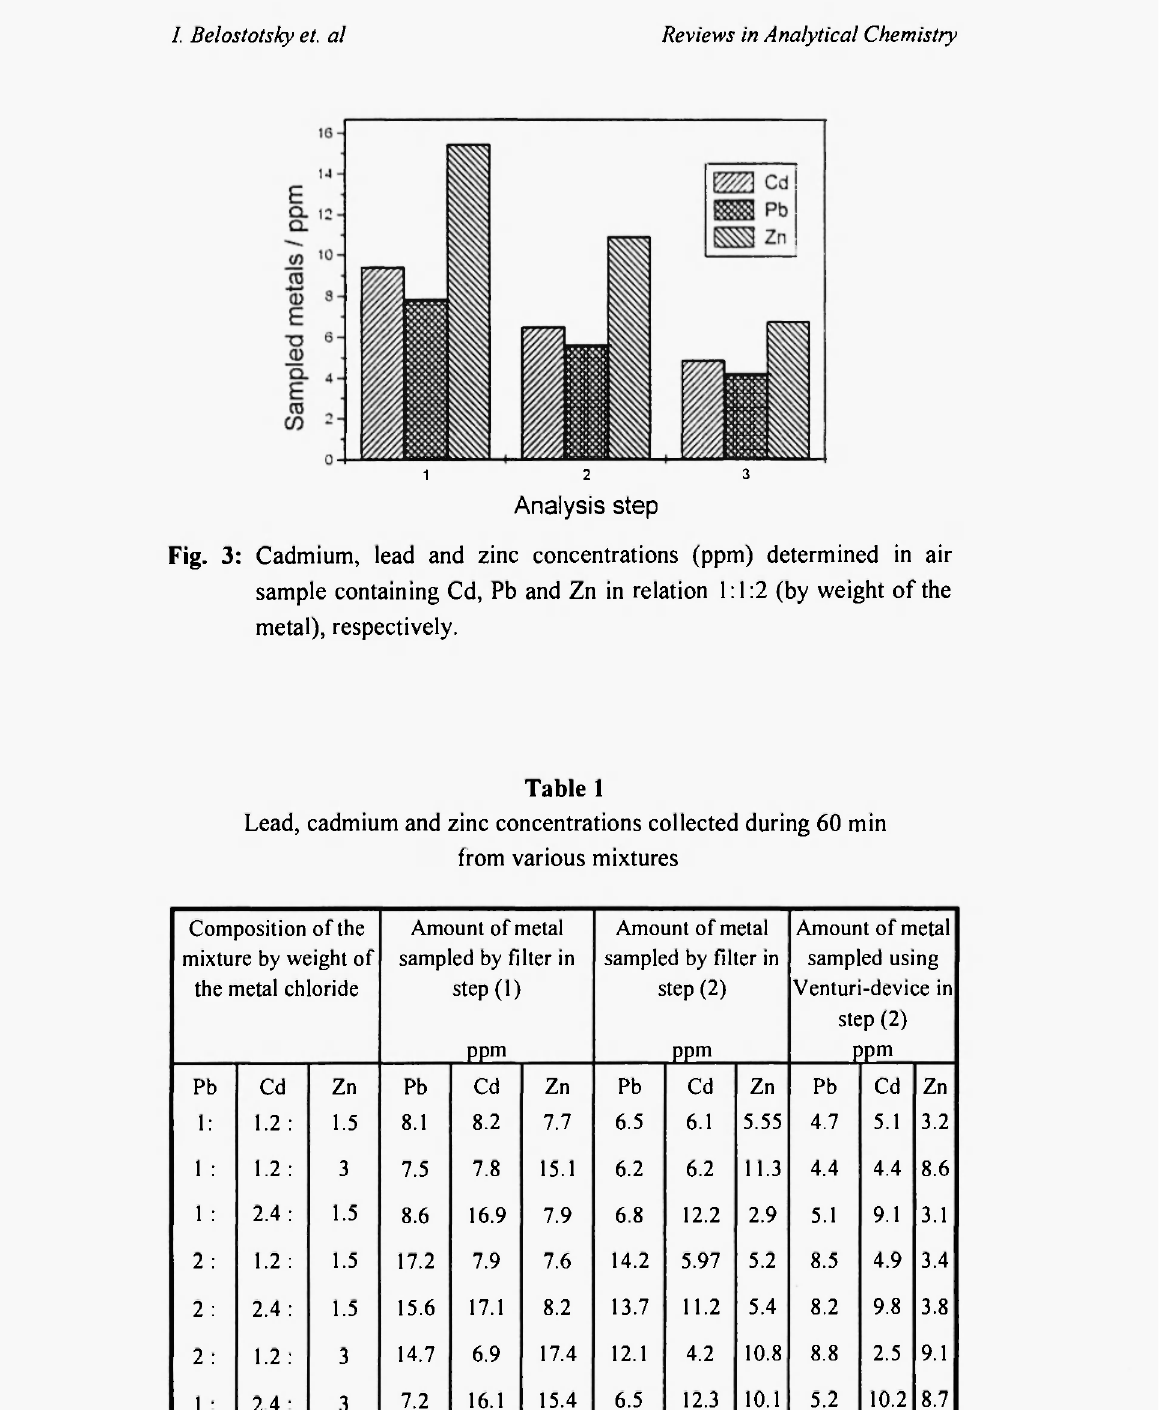
Fig. 3: Cadmium, lead and zinc concentrations (ppm) determined in air sample containing Cd, Pb and Zn in relation l: l :2 (by weight of the metal),